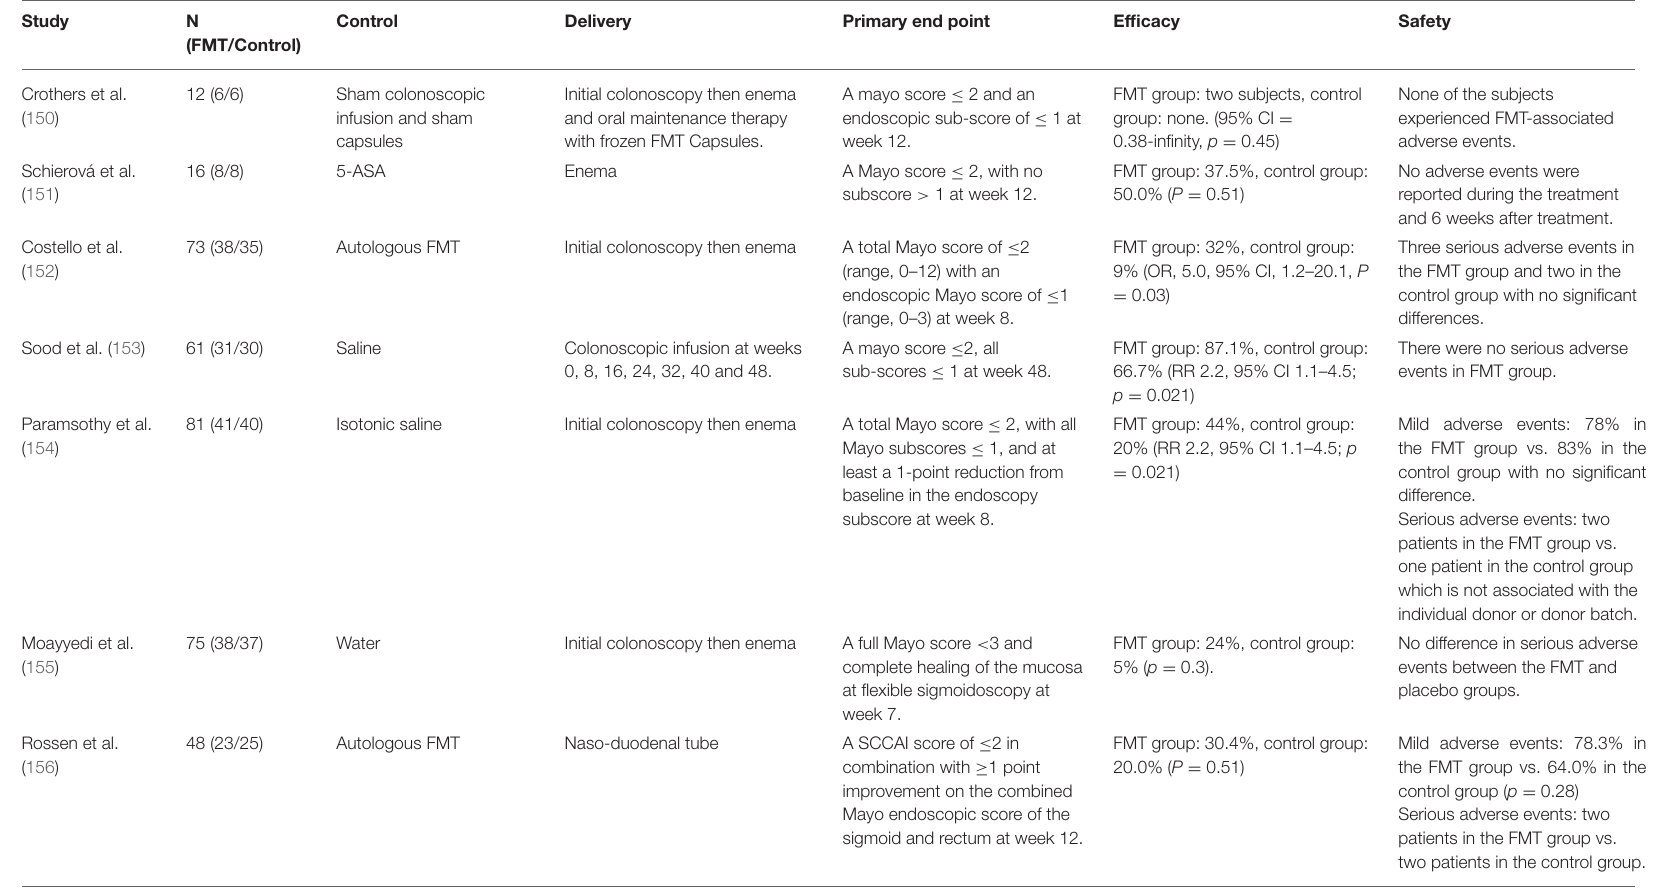
TABLE 2 | The characteristics of some randomized controlled trials of FMT for treating